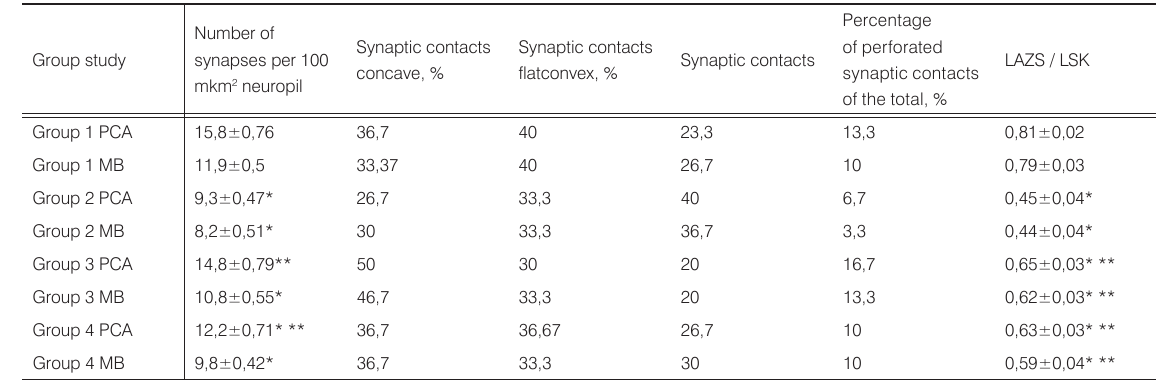
Figure 2. Axon-arrow activated neurons synapse concave punch TCD layer II of rabbit brain with experimental mild crani- ocerebral injury after magneto-laser therapy. Reduce swell- ing, swelling of the synaptic apparatus. PS full synaptic vesicles. Hypertrophic MTX in synaptic terminals. Electron micrograph, increase x 22 Table 1. Morphometric characteristics of interest rate (%) value for different types of synaptic contacts, axo-spine and axo-dendritic synapses parietal cortex area and the midbrain rabbits with different bending plane of contact in rabbits with experimental mild traumatic brain injury before and after magnetic laser therapy (M±m).